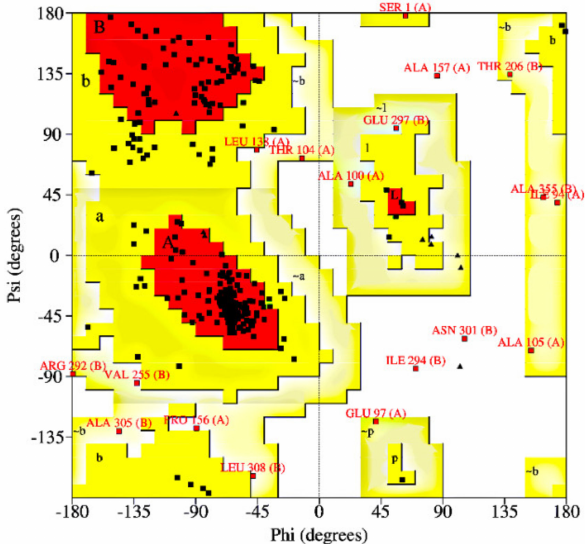
Figure 5. The Ramachandran plot of ToBRFV CP homology model. There are 218 residues located in the most favored region (red), 51 residues in the additional allowable region (yellow), 14 residues in the generous allowable region (light yellow), and only 3 residues in the prohibited region (white). Gly is plotted as triangles, Pro is plotted as squares, and all other residues are plotted as